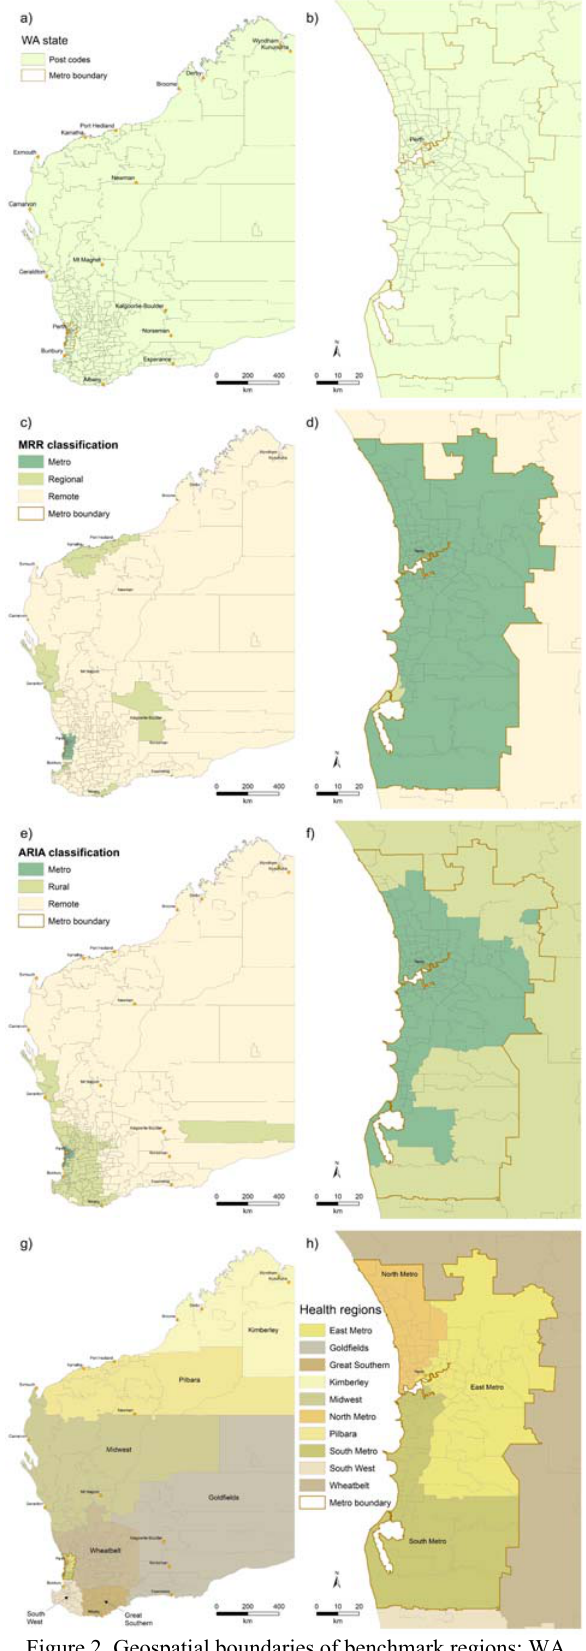
Figure 2. Geospatial boundaries of benchmark regions: WA state (a,b), Metro/regional/rural regions (c,d), ARIA-based regions (e,f) and Health Regions (g,